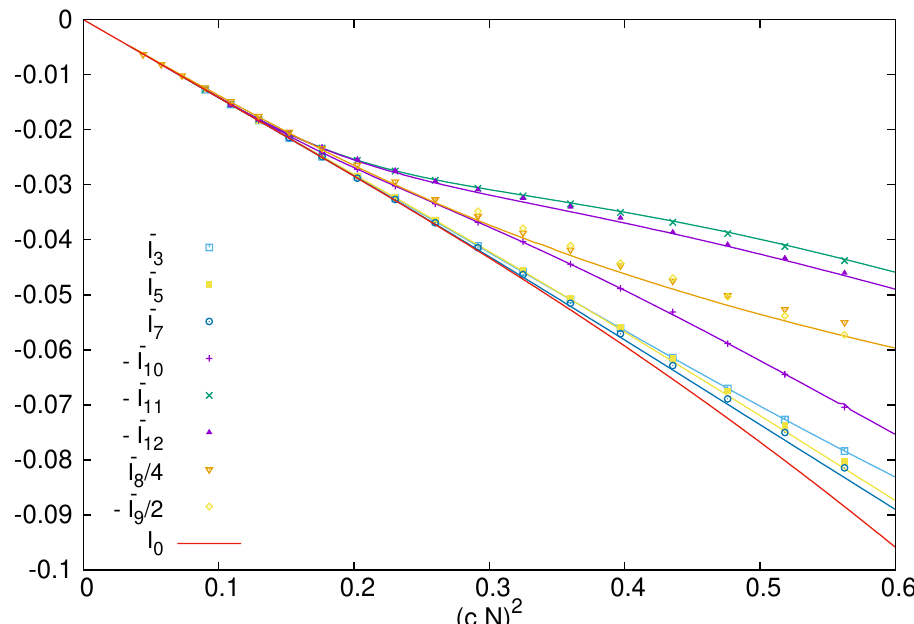
Figure 12. The contribution to C 1 from the integrals (cid:22) I i with i = 5 (cid:0) 10, shown as a function ( cN ) 2 . The continuous lines are obtained from the approximate expression given by the sum of eqs. (E.16) and (E.17). The red line represents I 0 as de(cid:12)ned in eq.